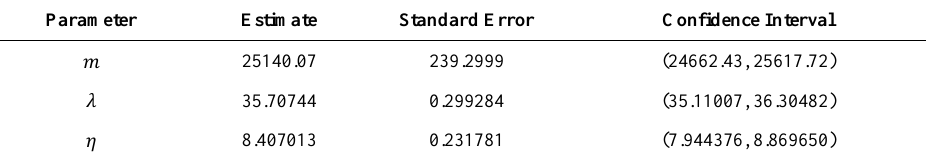
Table A24. Emilia–Romagna. Estimates, asymptotic standard errors and 95% mCIs for the parameters of the LOG model (2).